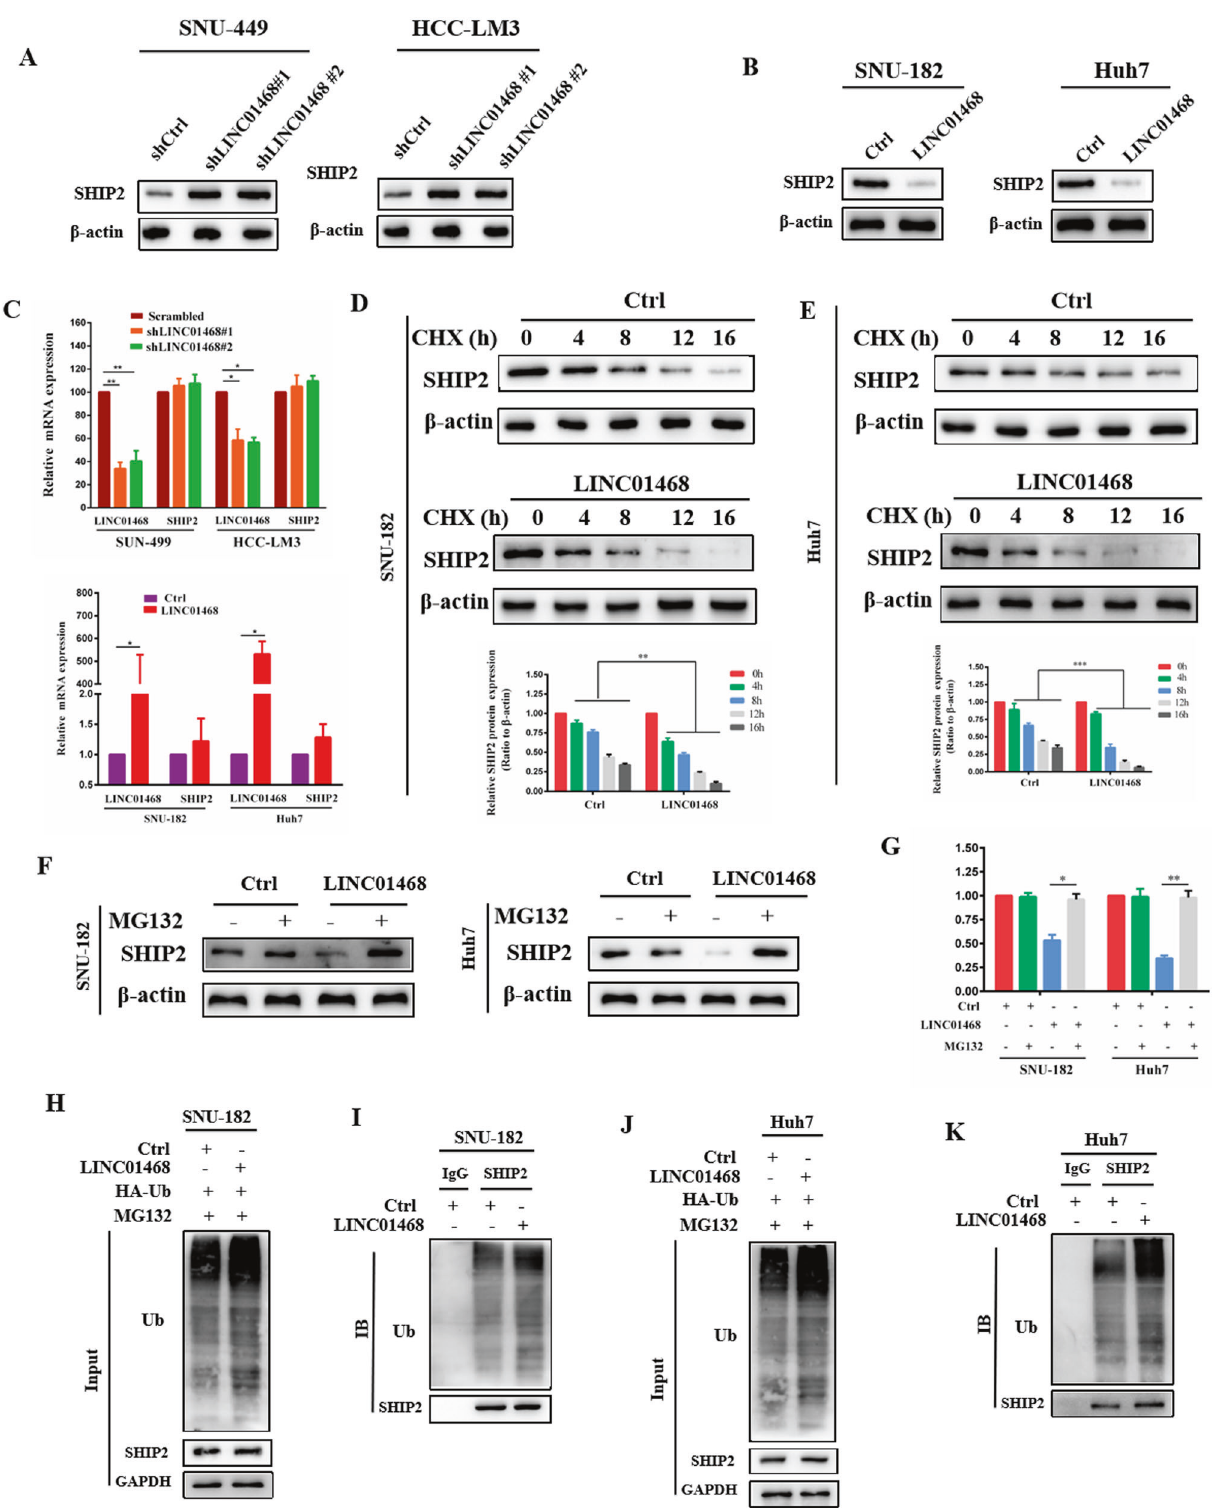
progression both in vitro and in animal models. Everolimus, an mTOR inhibitor, exhibits antitumor activity by disrupting various signaling pathways [27], and has been studied in combination with sorafenib in patients with unresectable or metastatic HCC [28]. Sorafenib combined with everolimus (an mTOR inhibitor) signi fi cantly reduced tumor growth and